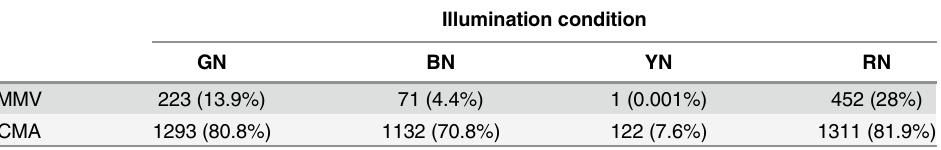
Table 2. The number and percentage of Munsell papers falling within the metamer mismatch volume (MMV) and chromaticity mismatch areas (CMA) of flat grey for four illumination conditions involving N